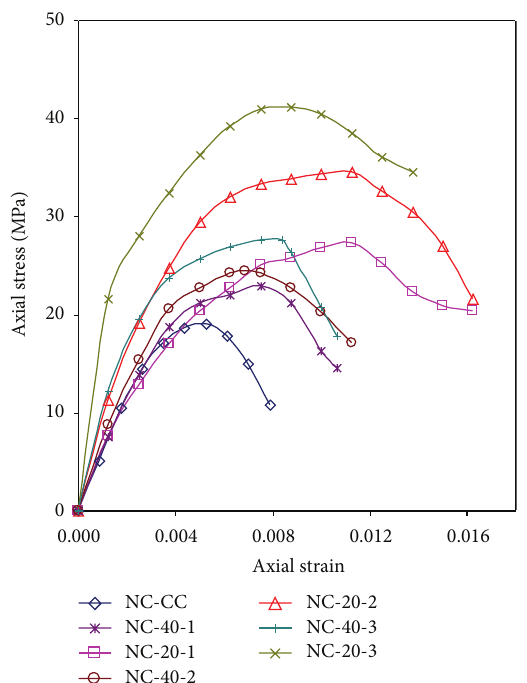
Figure 14: Axial stress-strain behaviour of all columns, comparison.